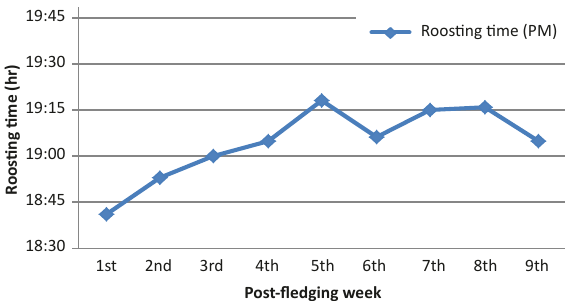
Figure 5. Roosting time of the fledglings during post-fledging 9 weeks (11 May- 6 Aug.) period. Average roosting time of per week showing here.